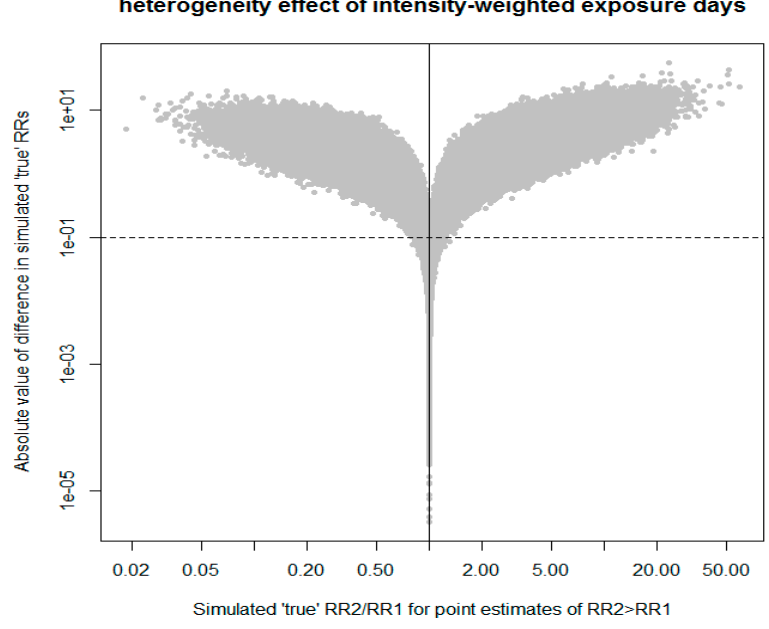
Figure 2. Comparing the results from De Roos et al. [2] with those from Sorahan [1] of the effect estimates for the highest category of intensity-weighted exposure days vs. the reference. When the simulated RRs are in the same order as the point estimates, they appear to the right of the solid vertical line; results of 1,000,000 simulated true RRs (see text for the details).